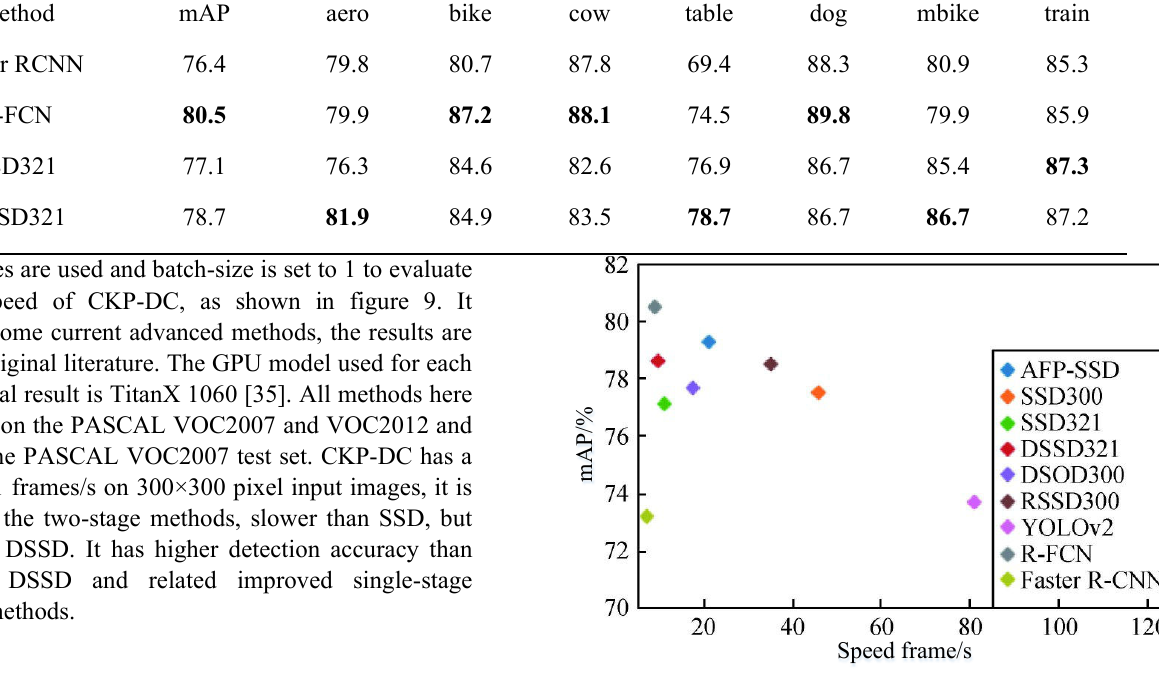
Figure 9. Comparison of accuracy and speed on PASCAL VOC2007 test set